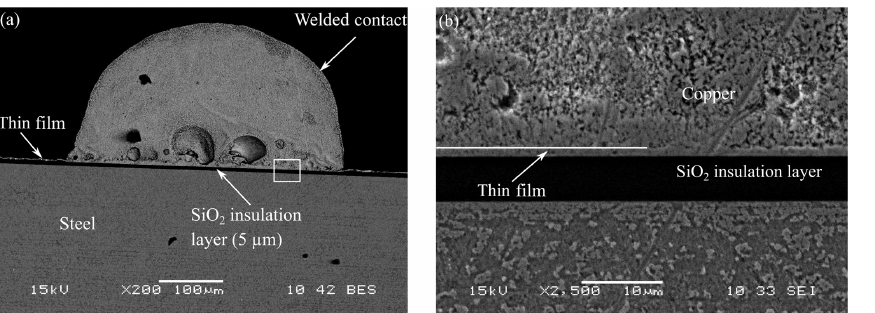
Figure 6. (a) SEM image of a cross section of a welded contact. (b) Enlarged detail of the marked rectangular zone at the interface between the thin film and the welded copper contact.